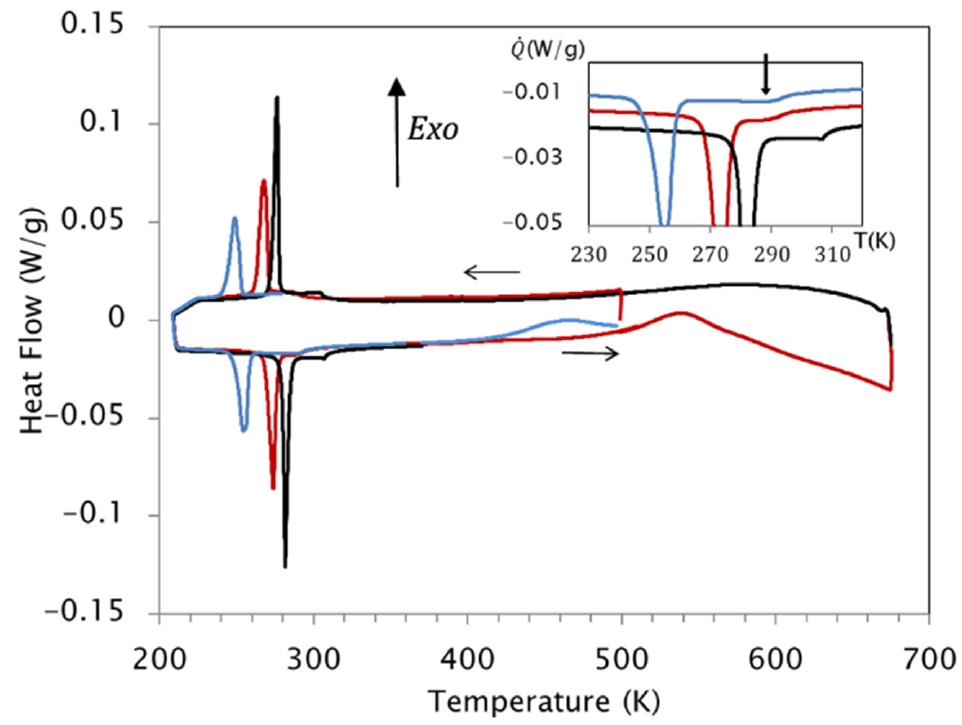
Figure 2. DSC curves obtained on cooling and subsequent heating at 5 K/min, for a Cu 5 sample just after quench from 1020 K (blue curve), after overcoming P 2 (red curve), and after passing P 1 (full and dotted black curve). The inset shows an enlargement of the curves around the Curie temperature. Adapted from [22].